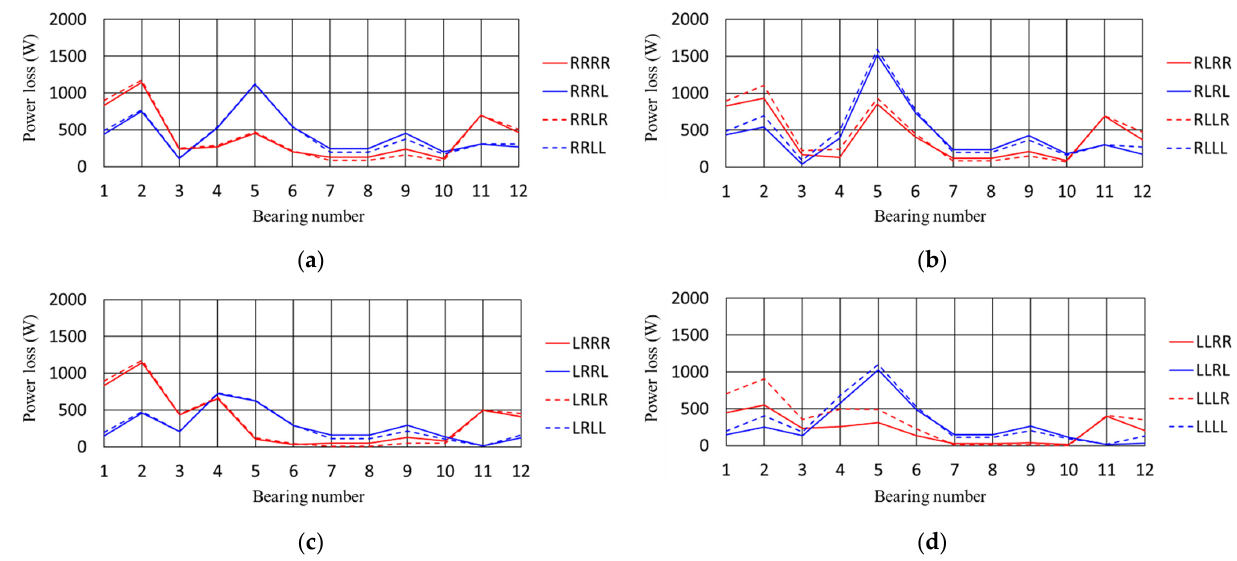
Figure 8. Bearing power losses of the entire combinations of helix angle directions. ( a ) RRRR/RRRL/RRLR/RRLL directions;